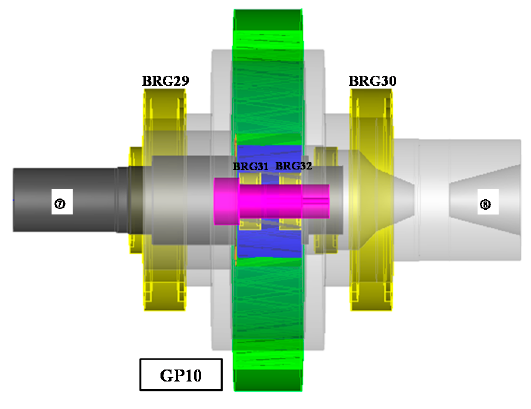
Figure 9. Layout of torque application gearbox.